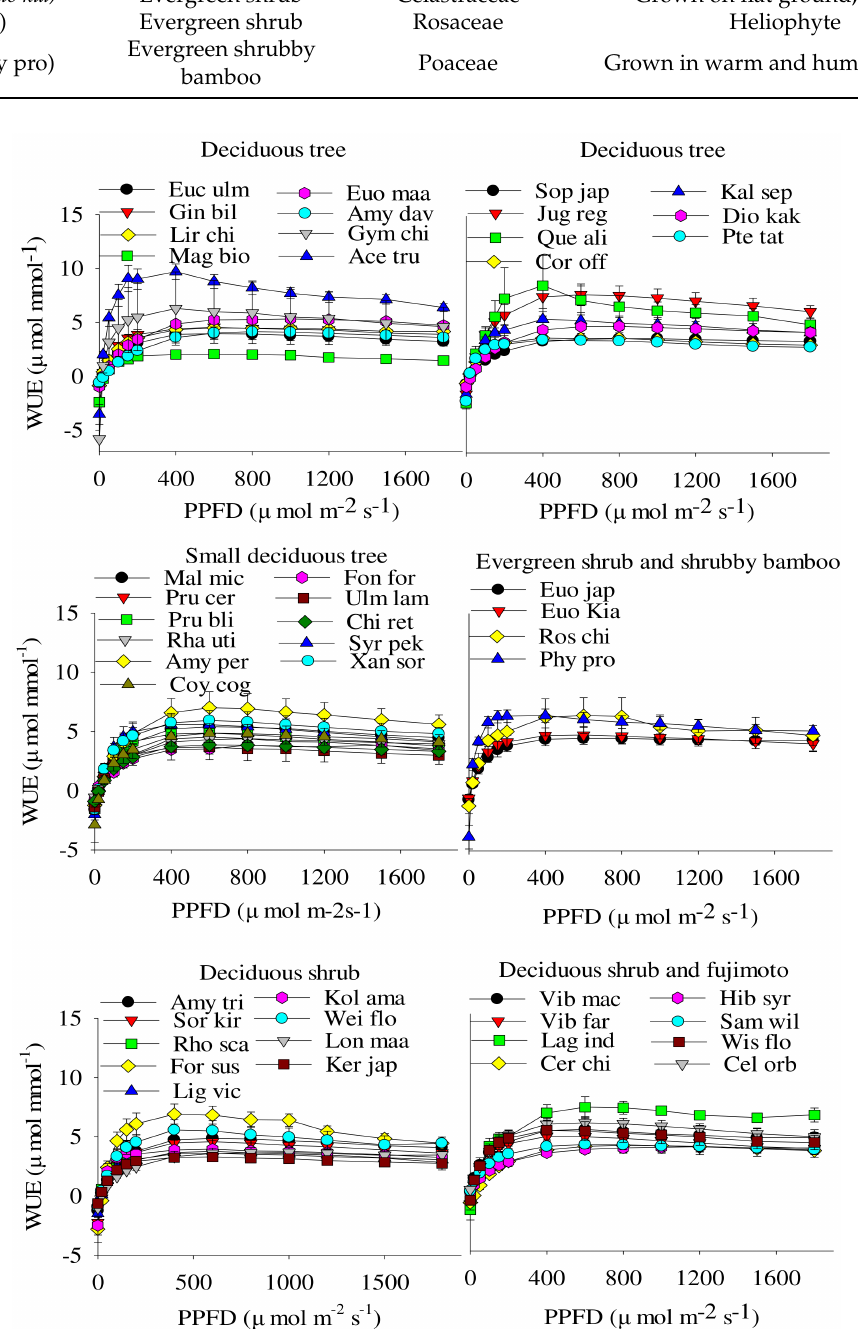
Figure 2. Water-use efficiency curves (mean ± SE, n = 5) of forty-seven woody species. WUE and PPFD are water-use efficiency and photosynthetic photon flux density, respectively. Species abbreviations are shown in Table